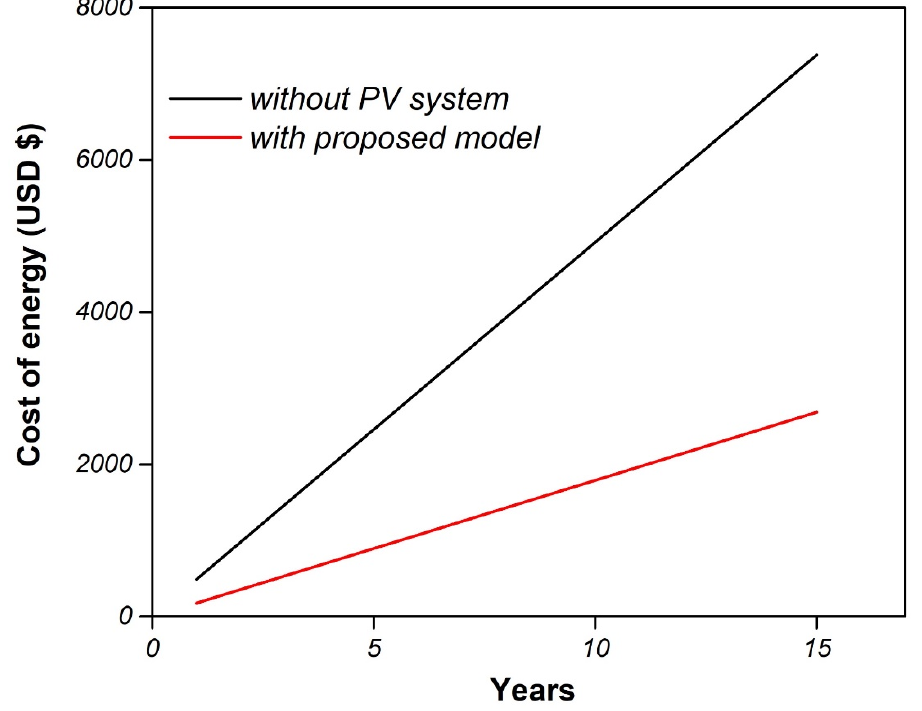
Figure 12. Comparison of a 15-year electricity bill with and without the proposed system.